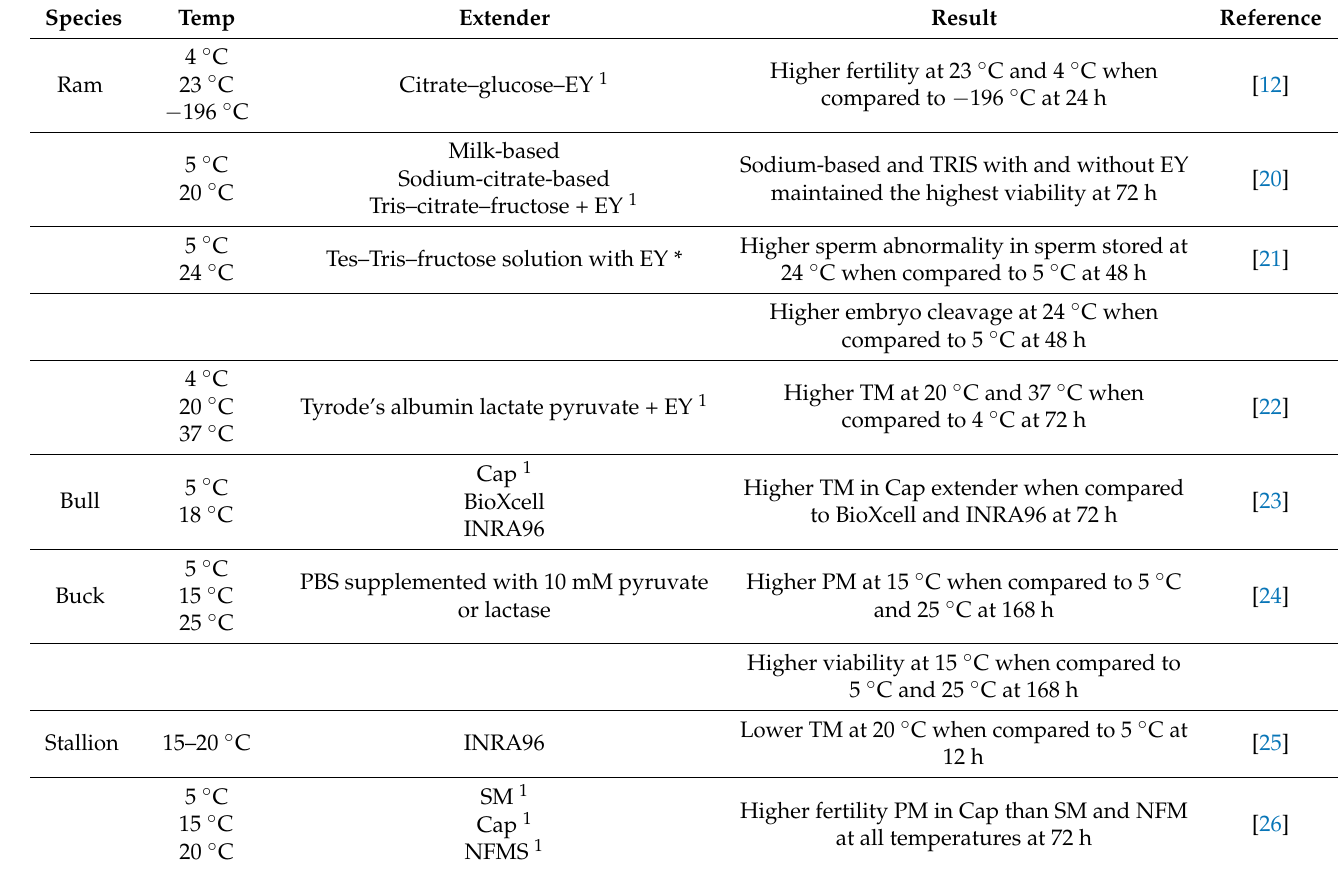
Table 1. Summary of publications investigating semen storage temperatures between 20–37 ◦ C in various